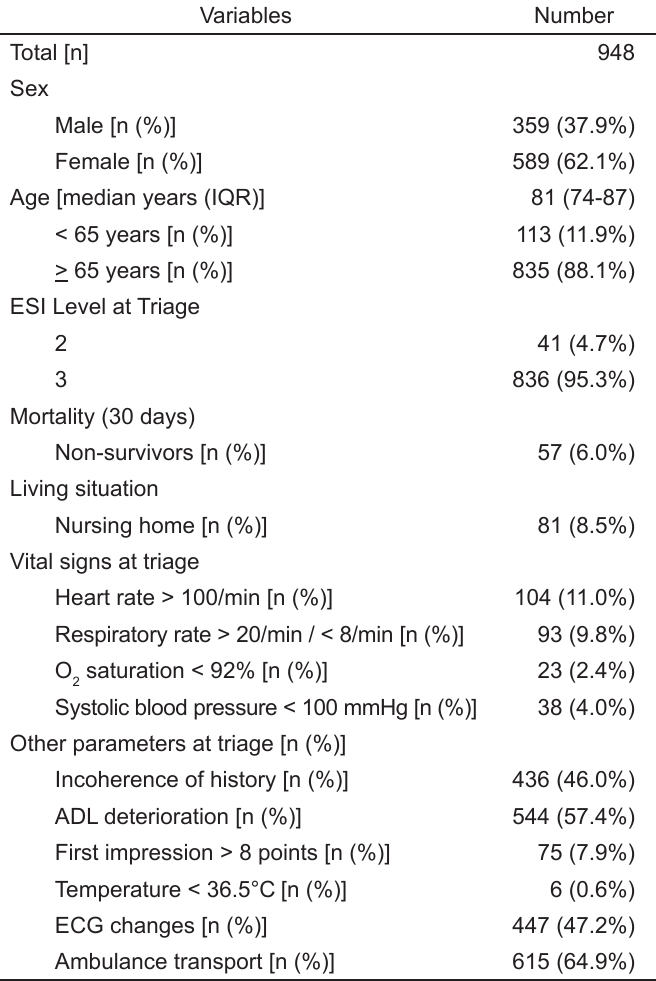
Table 2. Baseline and demographic